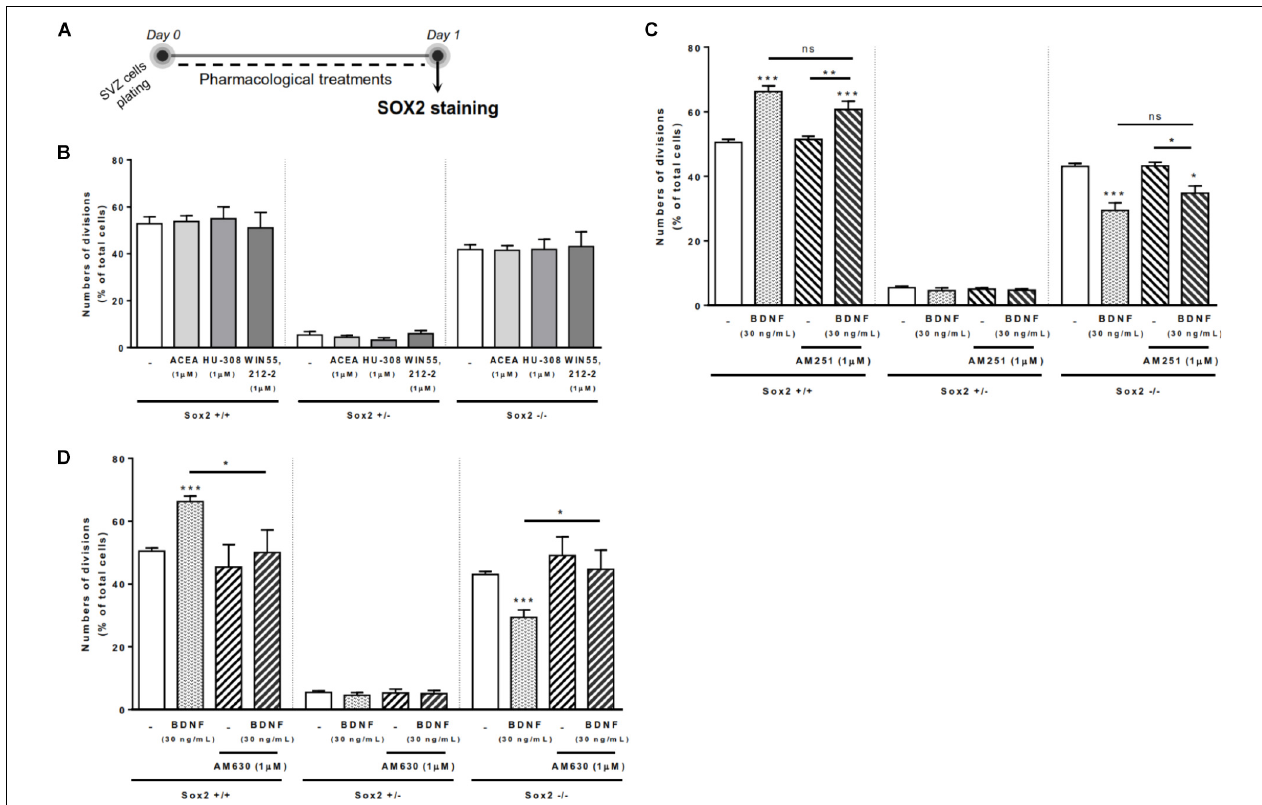
FIGURE 1 | BDNF-CB2R interaction regulates SVZ self-renewal. BDNF treatment promoted an increase in self-renewing capacity of SVZ cells which was blocked by CB2R antagonism, albeit cannabinoid receptor activation had no effect. (A) Schematic representation of the experimental protocol used to study cell-fate. Day 0 represents the day of cultures where the SVZ cell suspension was treated with the drugs for 24 h. (B–D) Bar graphs depict the percentage of Sox2+/+, Sox2+/–, Sox2–/– cell pairs expressed as percentage of total cells per culture. Data are expressed as mean ± SEM. n = 3–9. ∗ p < 0.05, ∗∗ p < 0.01 and ∗∗∗ p < 0.001 using Dunnett’s multiple comparison test. ns,